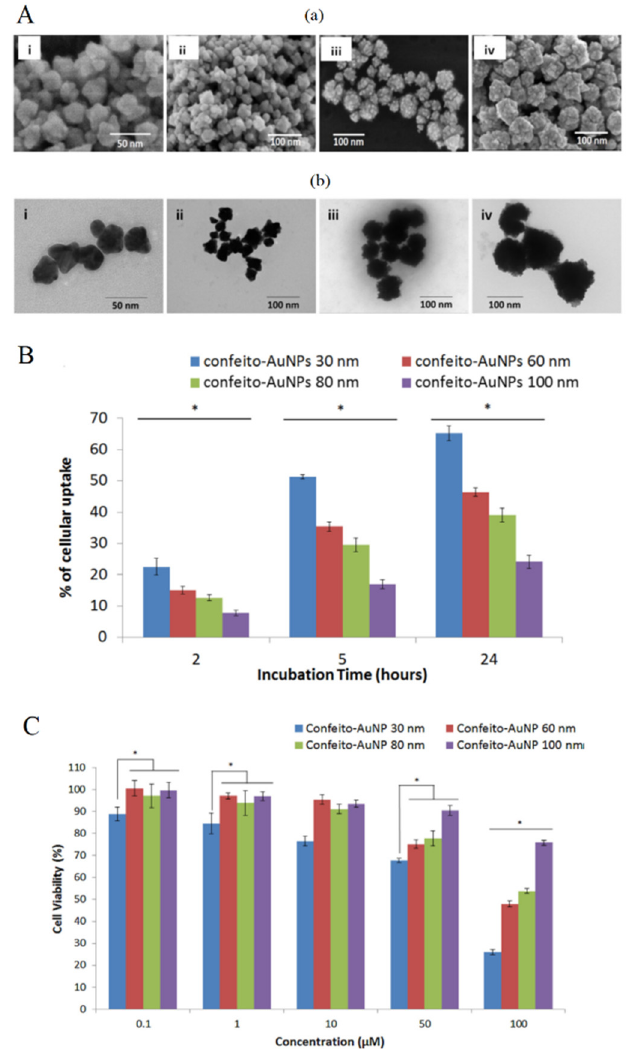
Figure 9. ( A ) Characterization of confeito-AuNPs at (i) 30 nm, (ii) 60 nm, (iii) 80 nm and (iv) 100 nm, by (a) FESEM images and (b) TEM images. ( B ) Evaluation of the cellular uptake of confeito-AuNPs into MDA-MB-231 cells. * p < 0.05 (ANOVA). ( C ) In vitro photothermal treatment: MDA-MB-231 cell viability after laser treatment (2 W/cm 2 , 1 min of irradiation) with confeito-AuNPs. * p < 0.05 (ANOVA) (adapted from Reference [120] with permission from Elsevier. Copyright 2018, Colloids and Surfaces B: Bio-interfaces).